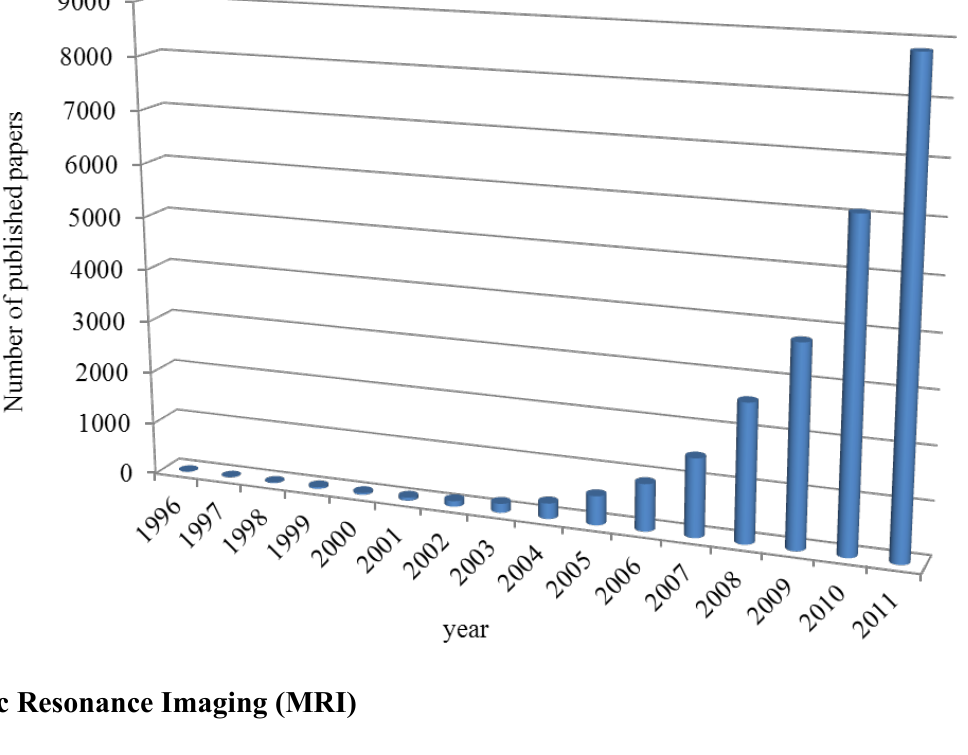
Figure 2. Published items each year containing ―imaging and nanoparticle * ‖ in